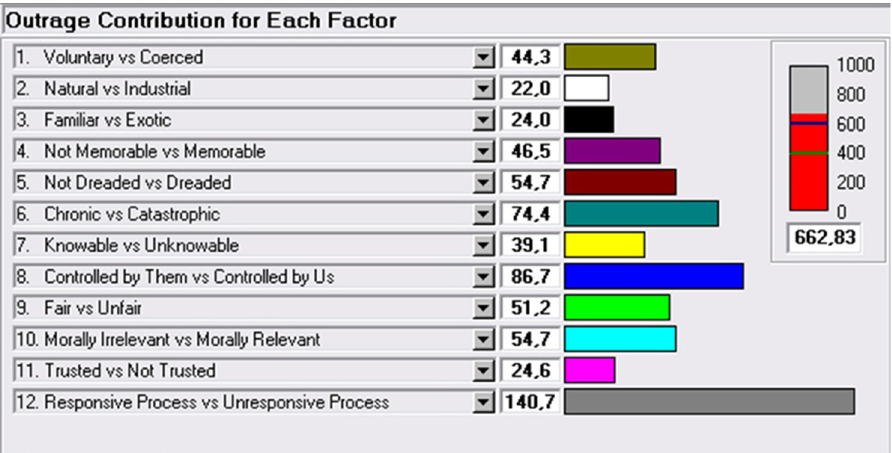
Figure 3. The contribution of each factor on the outrage assessment score obtained.